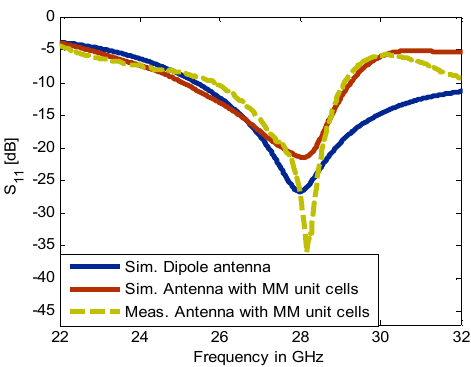
Figure 11. The simulated and measured reflection coefficient of the dipole antenna and MM antenna during the positive deflection.